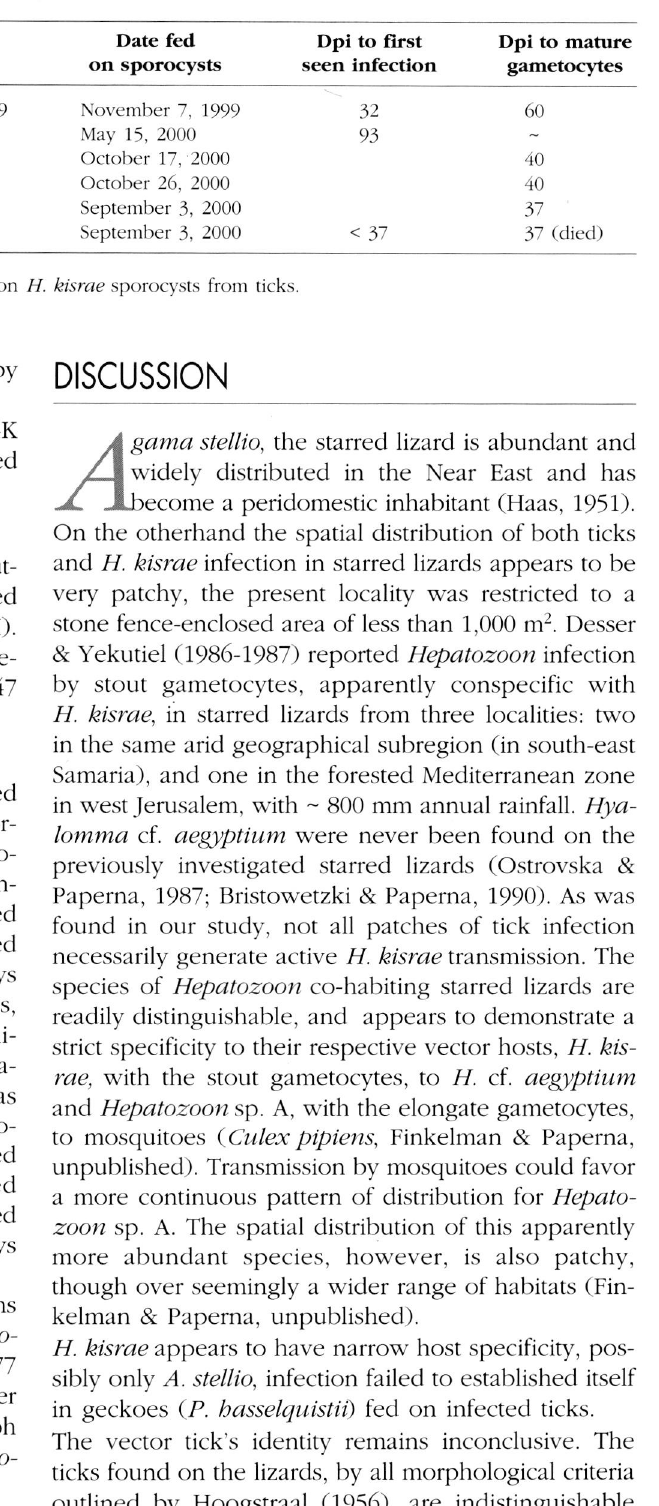
Table IV. - Experimental infection of starred lizards by feeding on H. kisrae sporocysts from